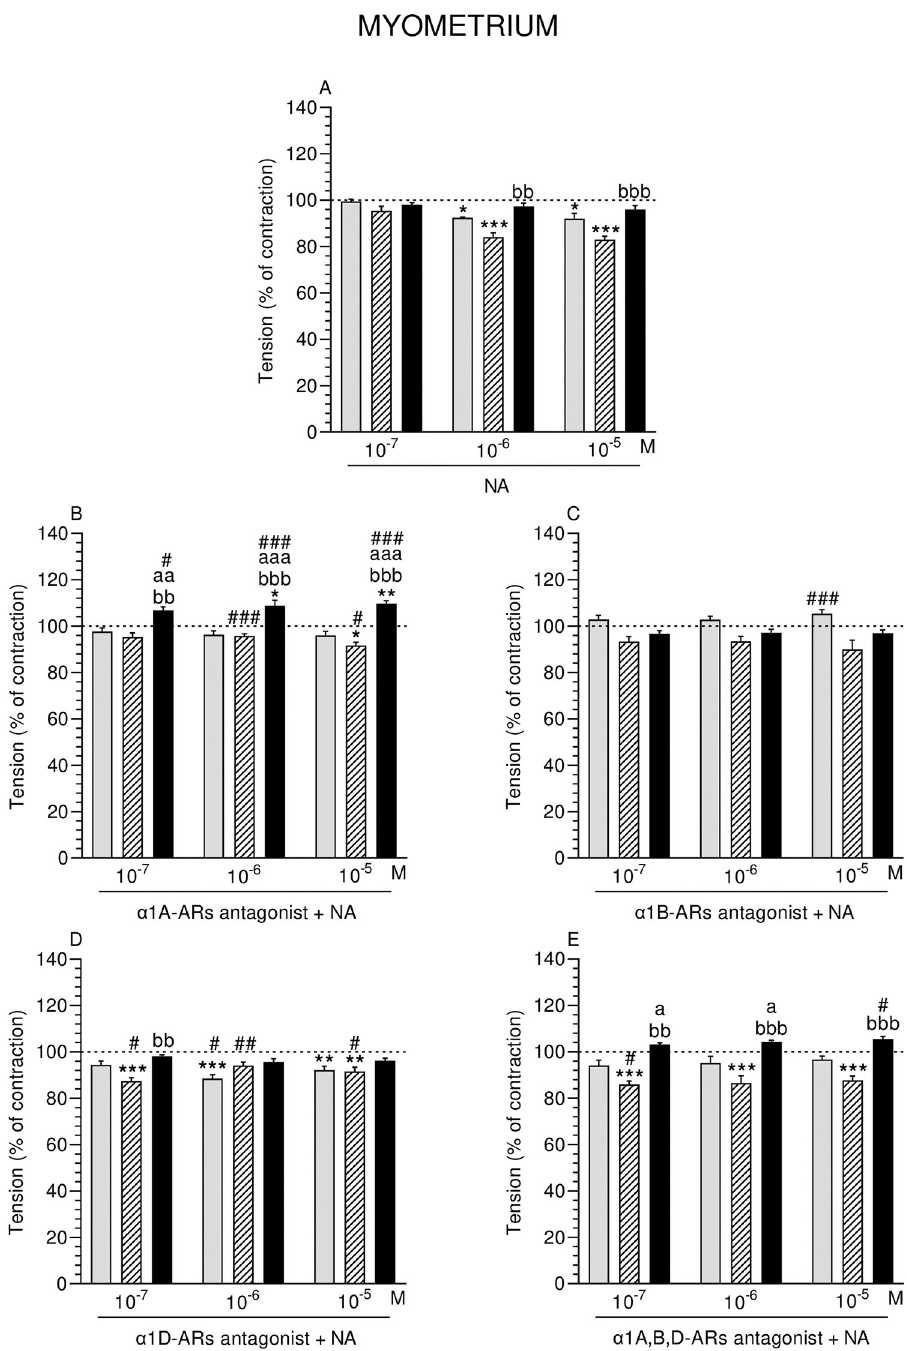
Fig 2. Effect of noradrenaline (NA) alone (A) and NA with α 1A- (B), α 1B- (C), α 1D- (D) and α 1A,B,D (E)– adrenoreceptors (ARs) antagonists (a dose of 10 − 4 M) on the tension of con-tractions in pig myometrium strips obtained from the CON (grey bars), SAL (hatched bars), and E . coli (black bars) groups. Data from five experiments (gilts, in each group). Effects of particular doses of NA and antagonists are expressed as percentage (mean ± SEM) in relation to the basal (pre-treatment period) contractile tension, established as 100% (horizontal lines). � P < 0.05, �� P < 0.01, ��� P < 0.001—indicate differences from baseline in each group; a P < 0.05, aa P < 0.01, aaa P < 0.001- indicate differences between CON and E . coli groups for the same treatment; bb P < 0.01, bbb P < 0.001— indicate differences between SAL and E . coli groups for the same treatment; # P < 0.05, ## P < 0.01, ### P < 0.001 compared between particular antagonist with NA effect versus NA effect alone for the same group/NA